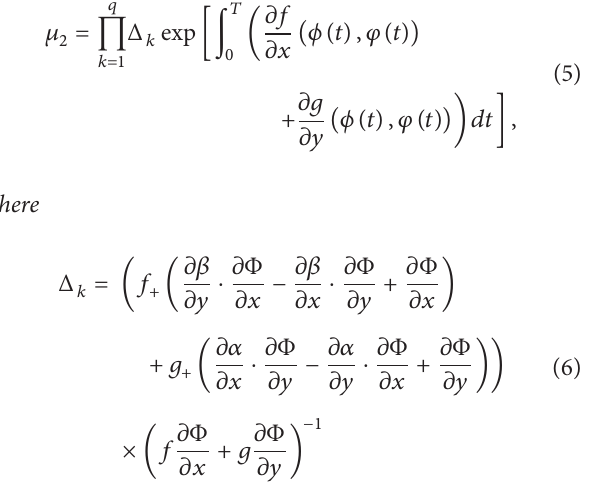
predation rate of natural enemies, and 𝑐 is the growth rate of natural enemies, after digestion and absorption. 𝑑 is the death rate of natural enemies. ℎ 1 and ℎ 2 are the threshold with slight damage and serious damage to the forest, respectively. 𝑦 ∗ is the ordinate of intersection of the line 𝑥 = ℎ (𝑟/(1 + 𝑎𝑥)) − 𝑏𝑦 = 0 . 𝛼, 𝜏 are the amount of natural enemies 𝑦(𝑡) released one time. 𝑝 and 𝑞 are death rates of pests and natural enemies due to pesticide, respectively. According to the biological significance, we only discuss 𝑅 2 + = {(𝑥, 𝑦) | 𝑥 ≥ 0, 𝑦 ≥ 0}